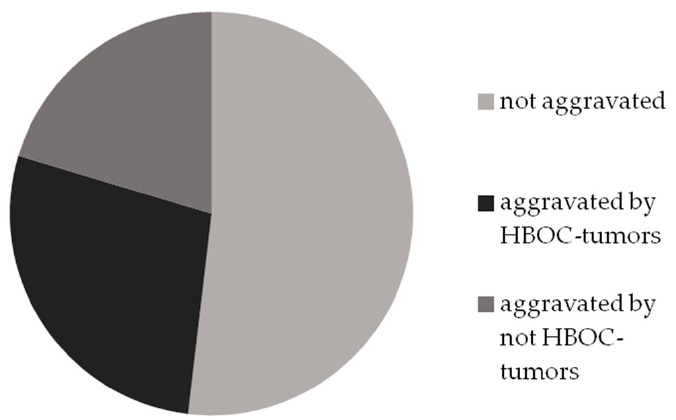
Figure 4. Aggravation of family histories by HBOC-spectrum cancers and other malignancies.